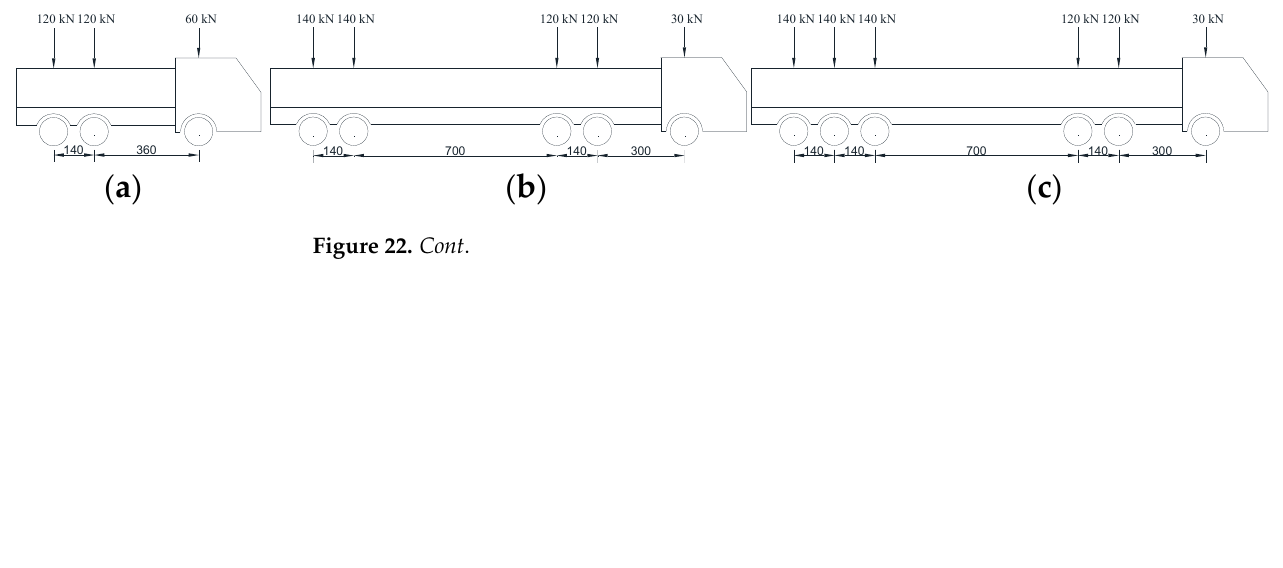
Table 5. Comparison of the predicted and experimental results.